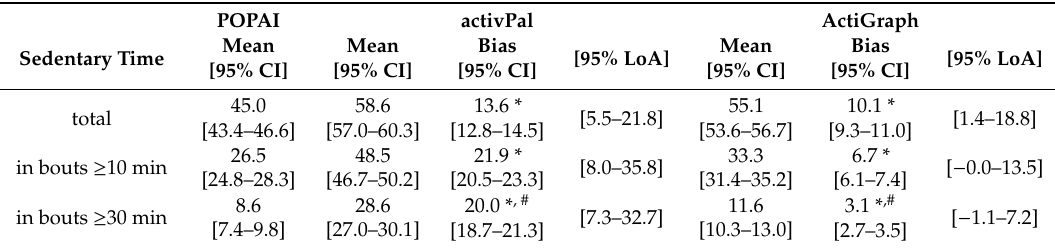
Table 1. Bland-Altman comparison of daily sedentary time. Average sedentary time for each method with activPal and ActiGraph bias and limit of agreement (LoA), indicated in % of waking hours. 100% equals 15.0 h, n = 100.